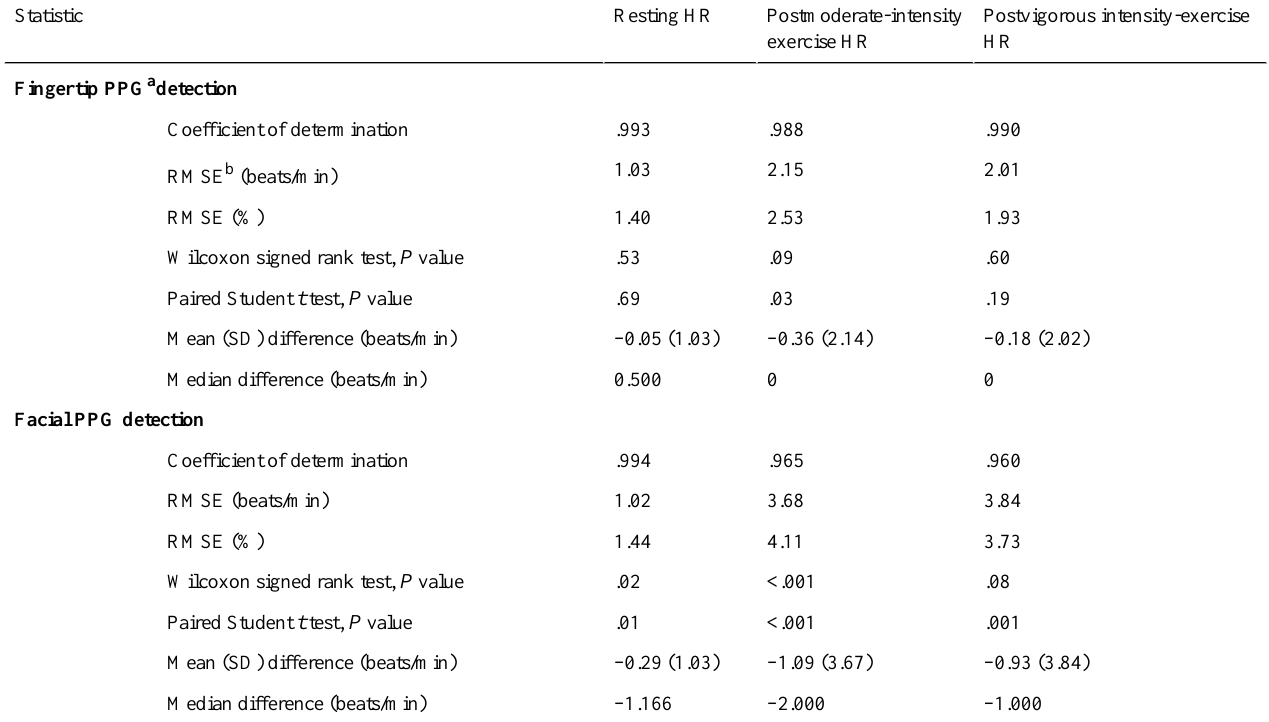
Table 3. Accuracy of measuring heart rate (HR) using Cardiio smartphone app compared with reference electrocardiogram.